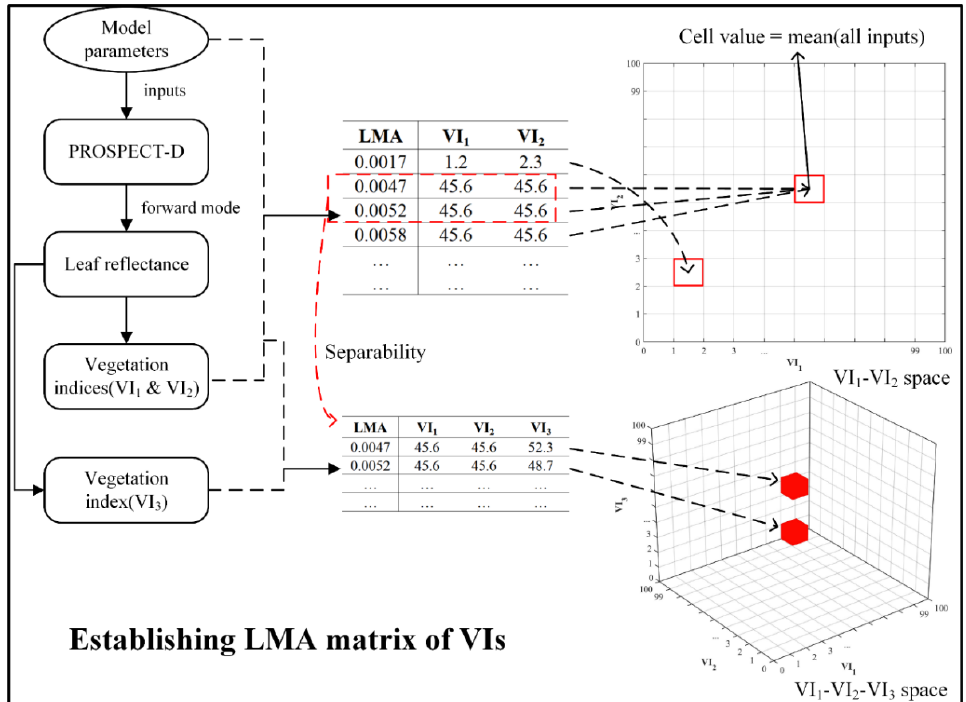
Figure 1. Establishment of the LMA 3D matrix.